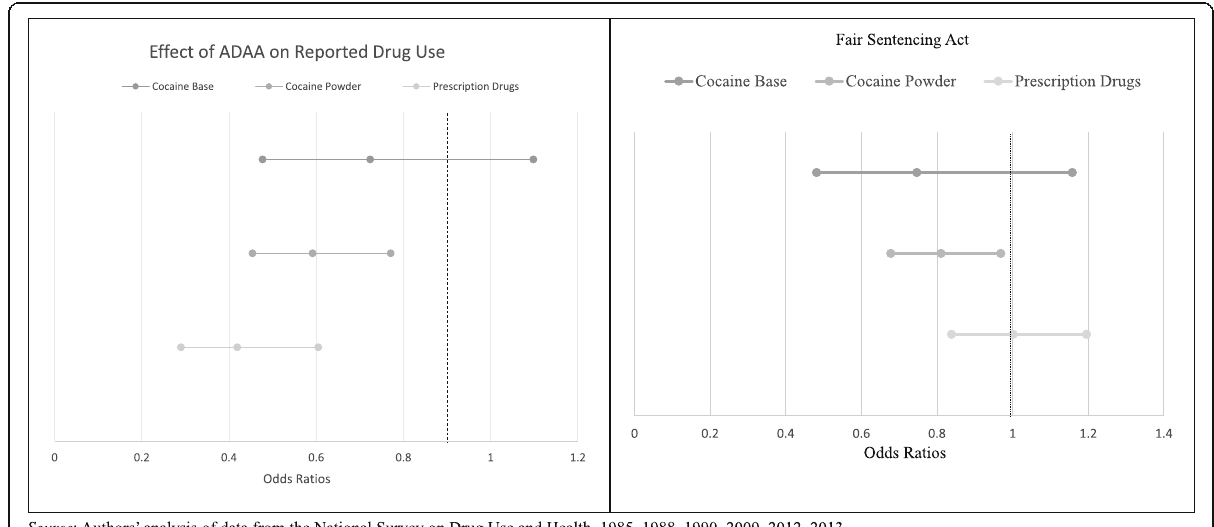
Fig. 2 Change in reported drug use after implementation of and relaxation of mandatory minimum sentencing